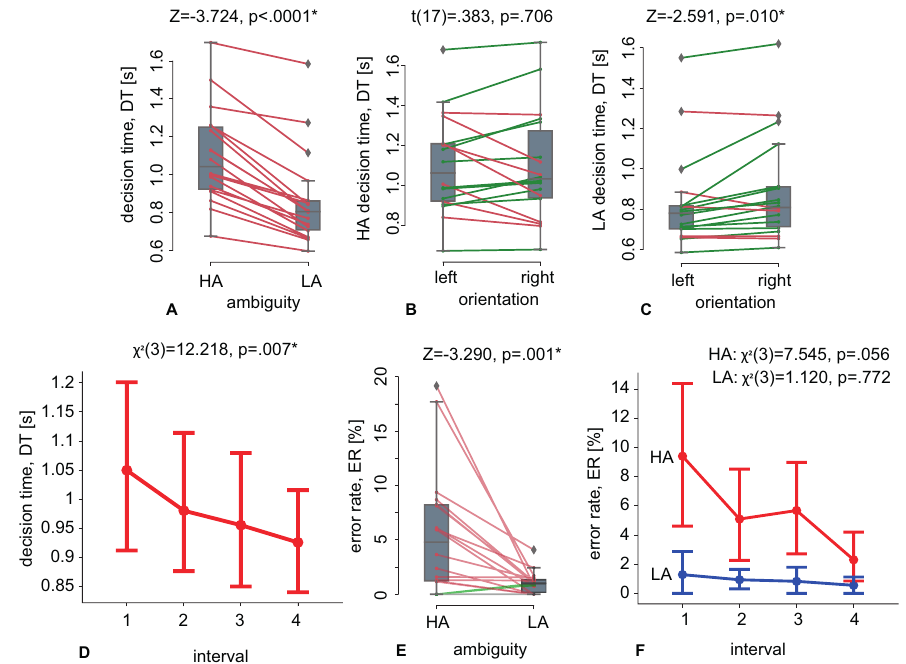
Figure 2. Results of the behavioral data analysis: ( A ) Median decision time, DT to HA and LA stimuli ( ∗ p < 0.0001 via Wilcoxon test, uncorrected). ( B ) Median DT to the left- and right-oriented HA stimuli ( p = 0.706 via t -test, uncorrected). ( C ) Median DT to the left- and right-oriented LA stimuli ( ∗ p = 0.01 via Wilcoxon test, uncorrected). ( D ) Median DT (group mean ± 95% CI) on four intervals ( ∗ p = 0.007 via Friedman test, uncorrected). ( E ) Percentage of erroneous responses (ER) to the HA and LA stimuli ( ∗ p = 0.001 via Wilcoxon test, uncorrected). ( F ) ER (group means ± 95% CI) on all intervals separately for HA ( p = 0.056 via Friedman test, uncorrected) and LA ( p = 0.772 via Friedman test, uncorrected)